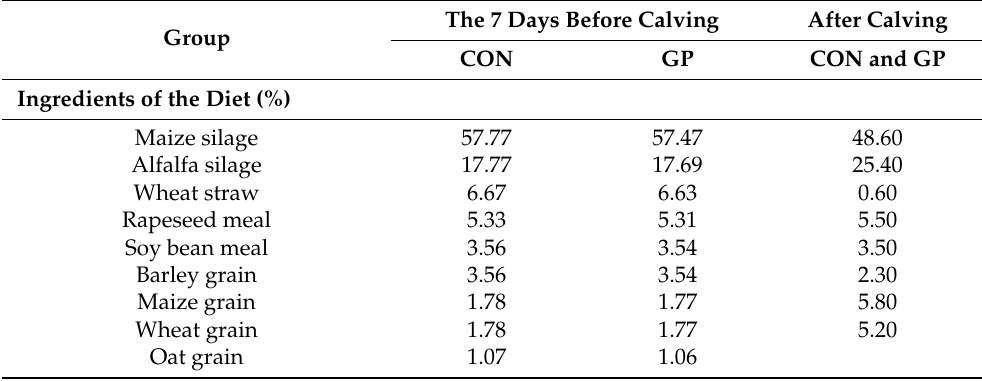
Table 1. The composition and nutritional characteristics of the diets provided for the 7 days before calving and after